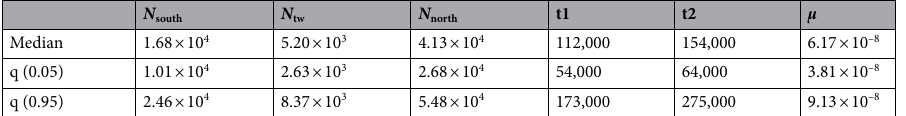
Table 3. Posterior median estimation and 95% highest posterior density interval (HPD) for demographic parameters in scenario 3 of Lindera aggregata in DIYABC. N south , N tw and N north represent current population size of southern, Taiwan and northern cluster; t1/t2, divergence times in years when a generation time of 10 years is applied for the depicted event; μ , mutation rate per generation per locus.